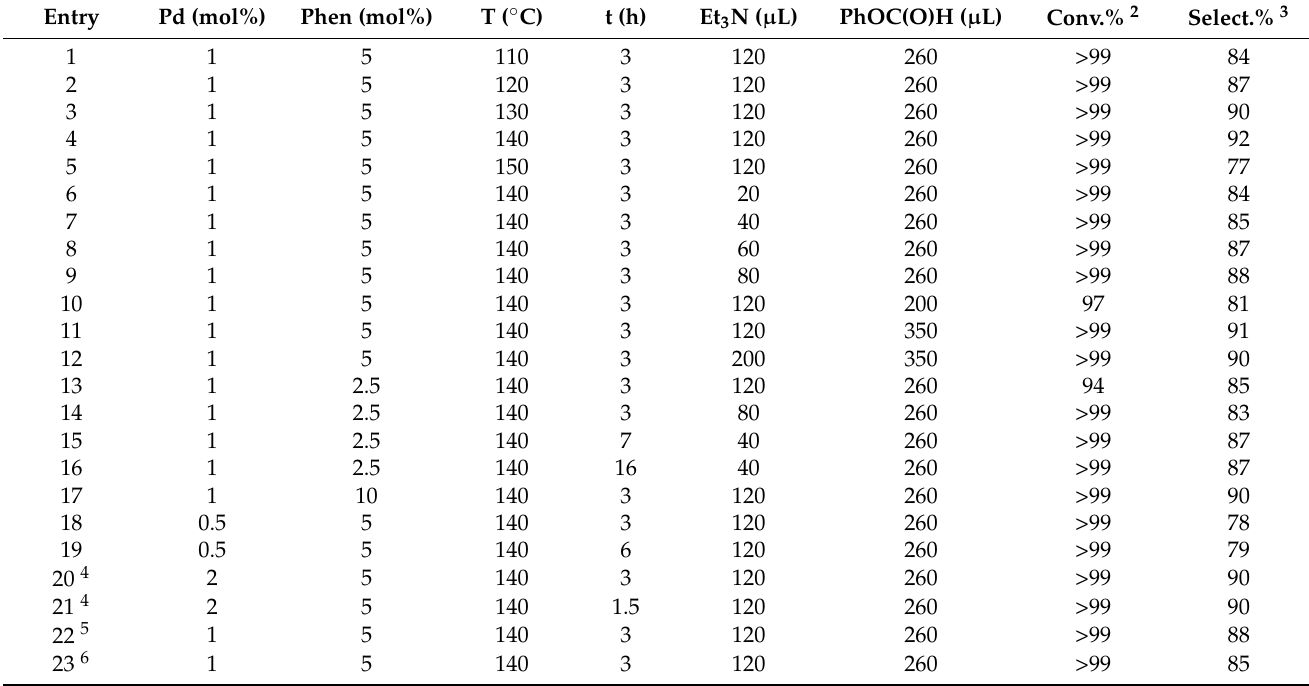
Table 2. Optimization of the reaction conditions for the reductive cyclization of α -phenyl- β